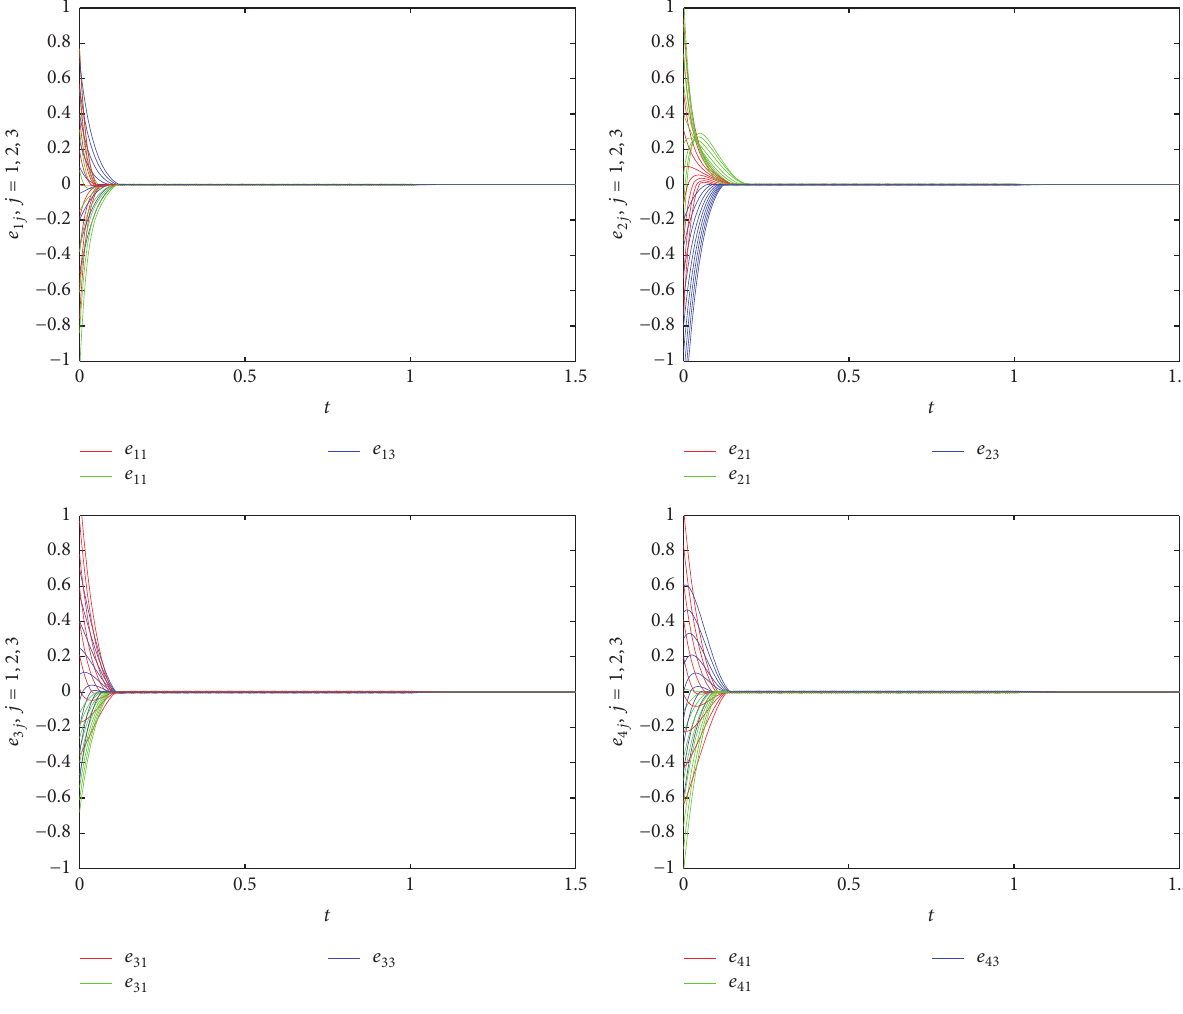
Figure 4: Time evolution of synchronization errors for (61) with different initial values.